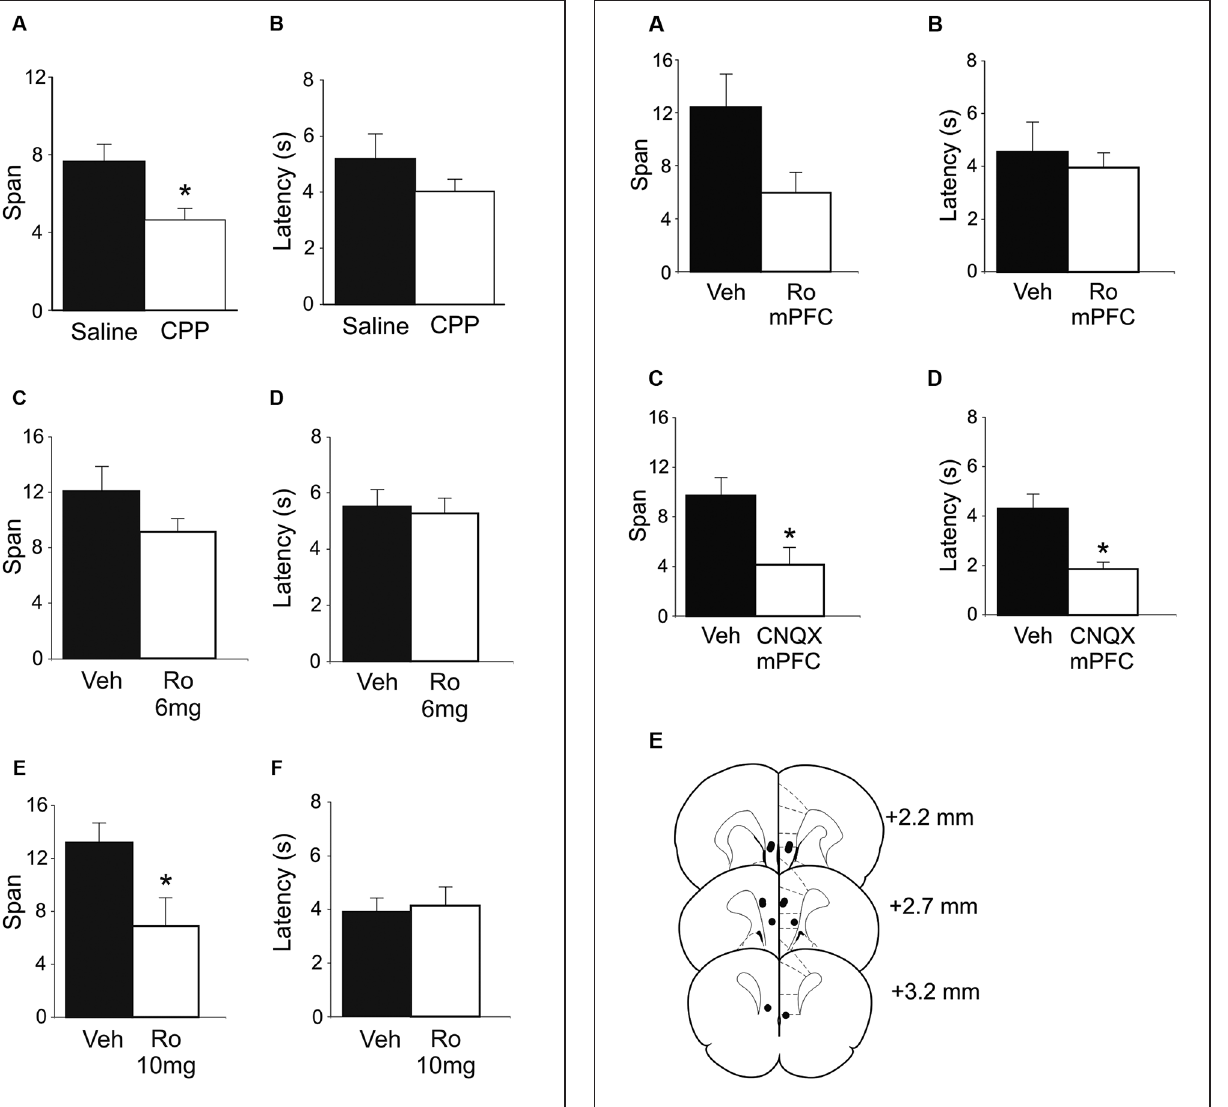
FIGURE 2 | Effects of systemic NMDA receptor antagonism on performance of the OST ( n = 8). (A) Mean spans of the rats following saline or CPP treatment (10 mg/kg, i.p.). (B) The mean latency of the rats to begin digging in a bowl (saline or CPP). (C) Mean spans for the rats following vehicle (Veh) or Ro 25-6981 (Ro) treatment (6 mg/kg, i.p.) (D) The mean latency of the rats to begin digging in a bowl during the tests conducted in C. (E) Mean spans for the rats following each treatment with either Veh or Ro 25-6981 (10 mg/kg, i.p.). (F) The mean latency of the rats to begin digging in a bowl (Veh or Ro, 10 mg/kg). * Refers to a significant difference between treatments ( p < 0.05).